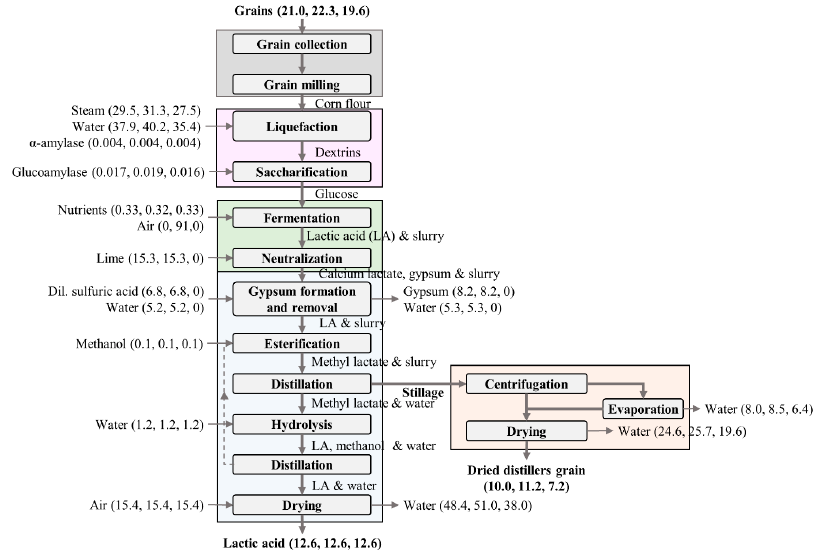
Figure 2. Material flow for lactic acid production from corn grain using three fermentation pathways using bacteria, fungi and yeast for a biorefinery with 100,000 t/yr production capacity (Note: All material flows are presented in t/h; first, second and third values within the parentheses represent material flows for bacteria, fungi and yeast-based pathways, respectively).